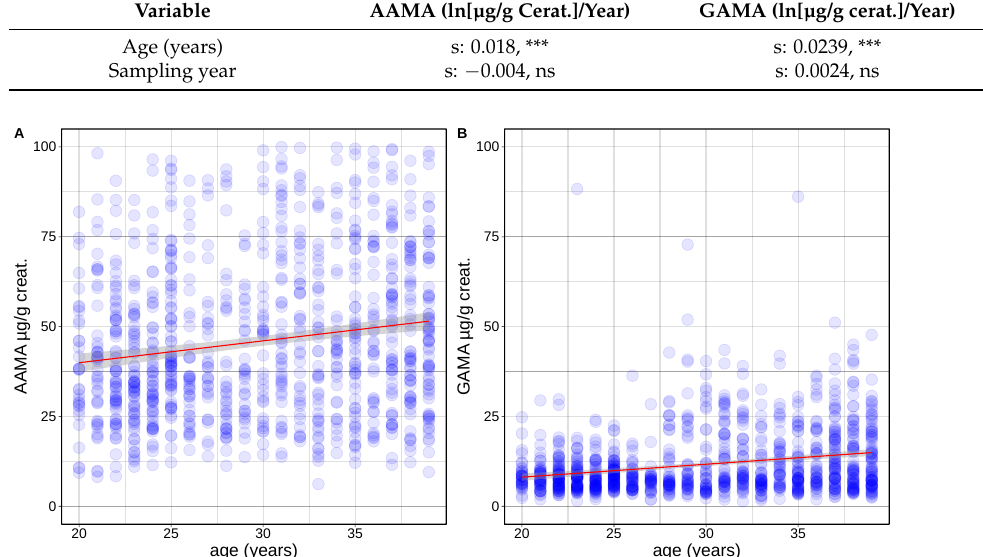
Figure 4. AAMA ( A ) and GAMA ( B ) (urine concentrations in µg/g creatinine) in function of age in non-smoking adults (20–39 years, Germany ESB; Luxembourg, LNS + LIH Oriscav-Lux2; Ice- land, Diet-HBM; France, ESTEBAN; and Portugal, INSEF-ExpoQuim). Linear fit in red, gray = 95% confidence